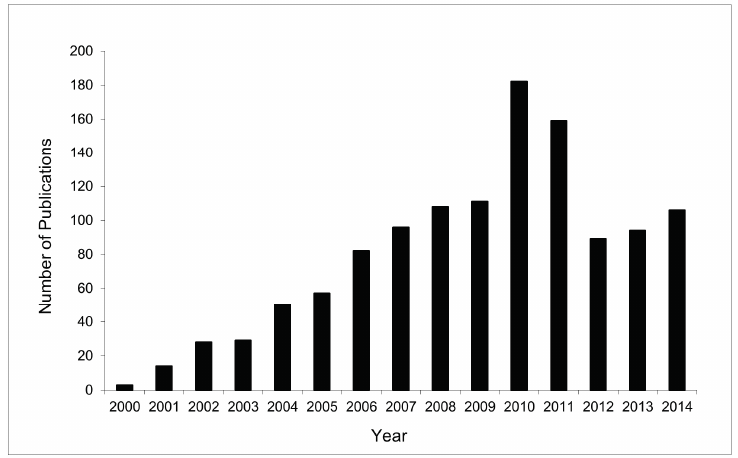
Figure 1. Year-wise reports published in the area of enzyme-based catalytic reactions in ionic